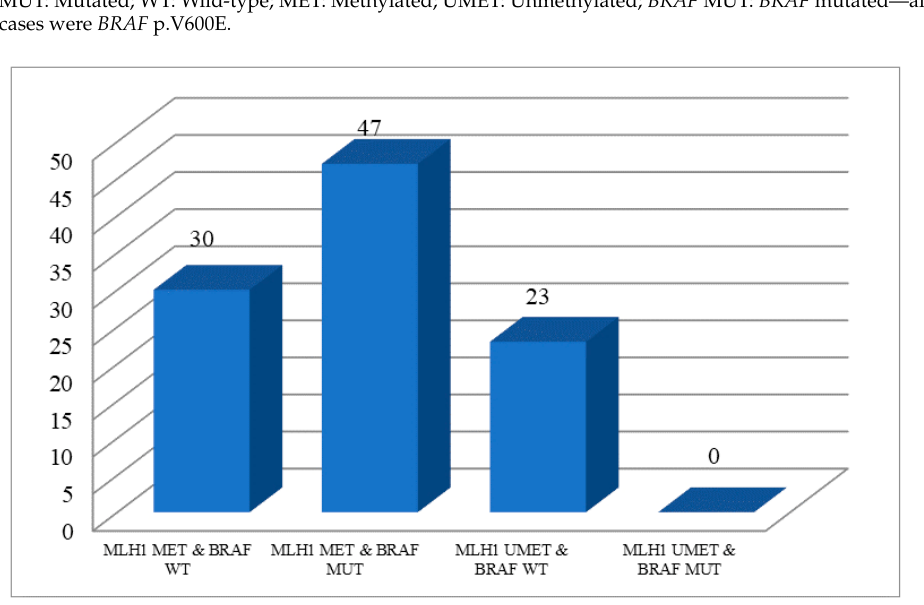
Figure 3. Number of samples according to BRAF and MLH1 molecular status. MET: Methylated; UMET: Unmethylated; WT: Wild-type; MUT: Mutated.